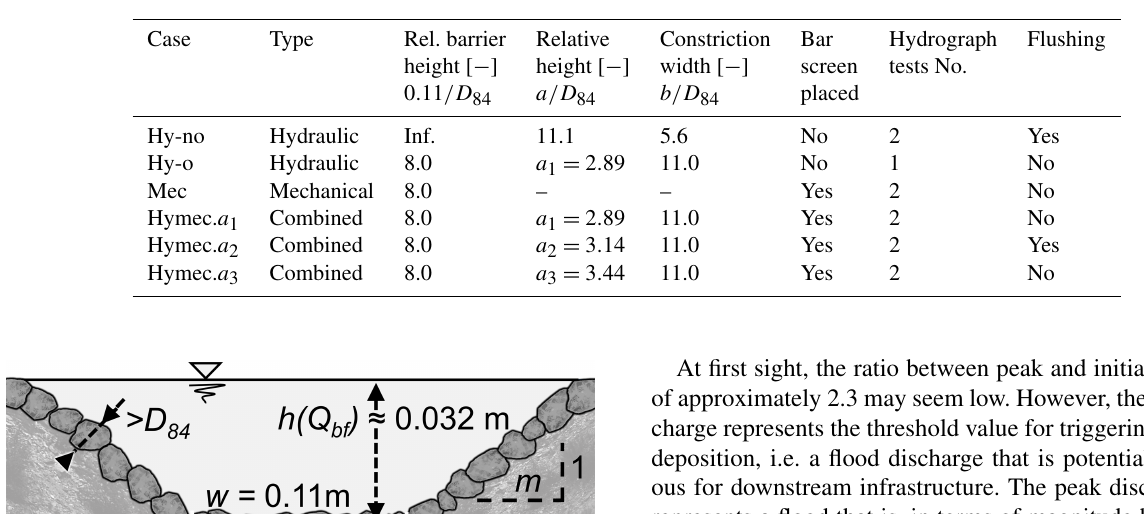
Table 1. Denomination and characterisation of test runs with hydrograph and flushing episodes.